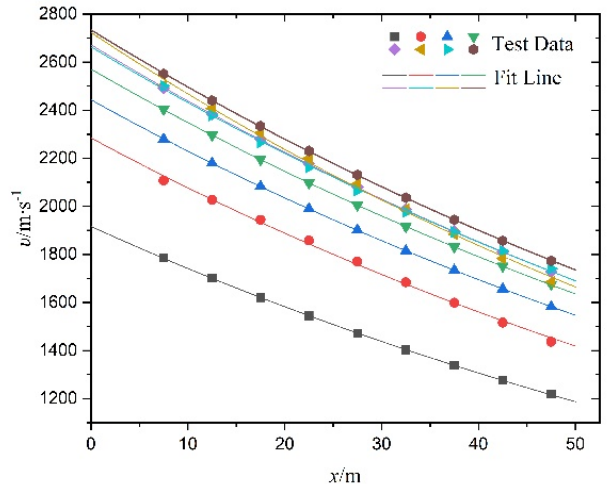
− velocity fitting Figure 9. Distance − velocity fi tt ing curve. Figure 9. Distance